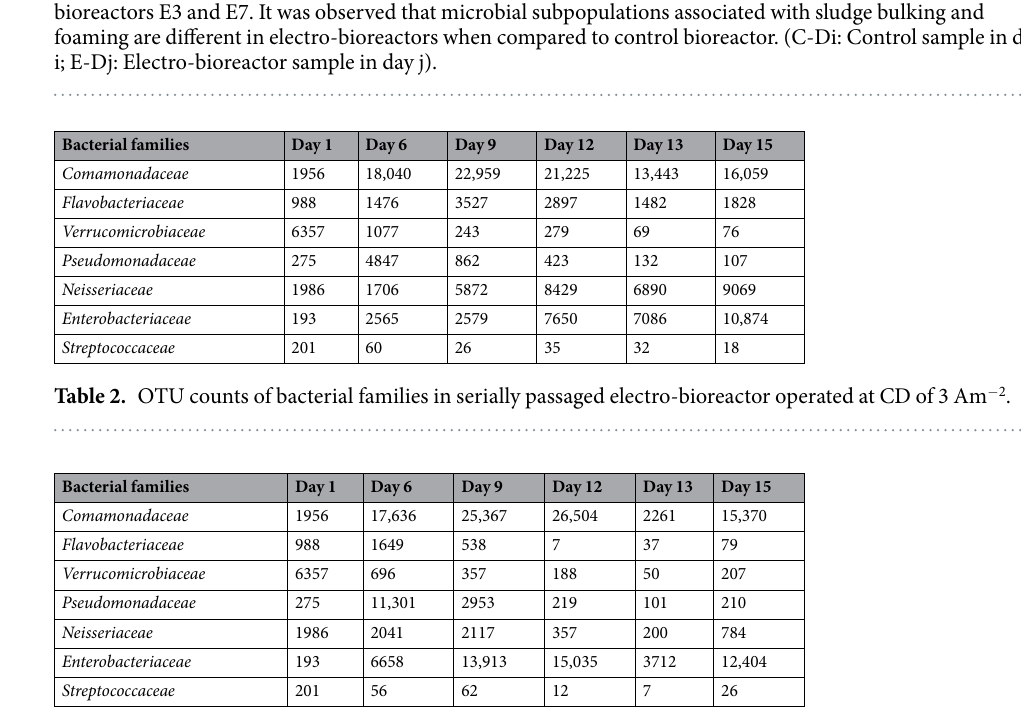
Table 3. OTU counts of bacterial families in serially passaged electro-bioreactor operated at CD of 7 Am − 2